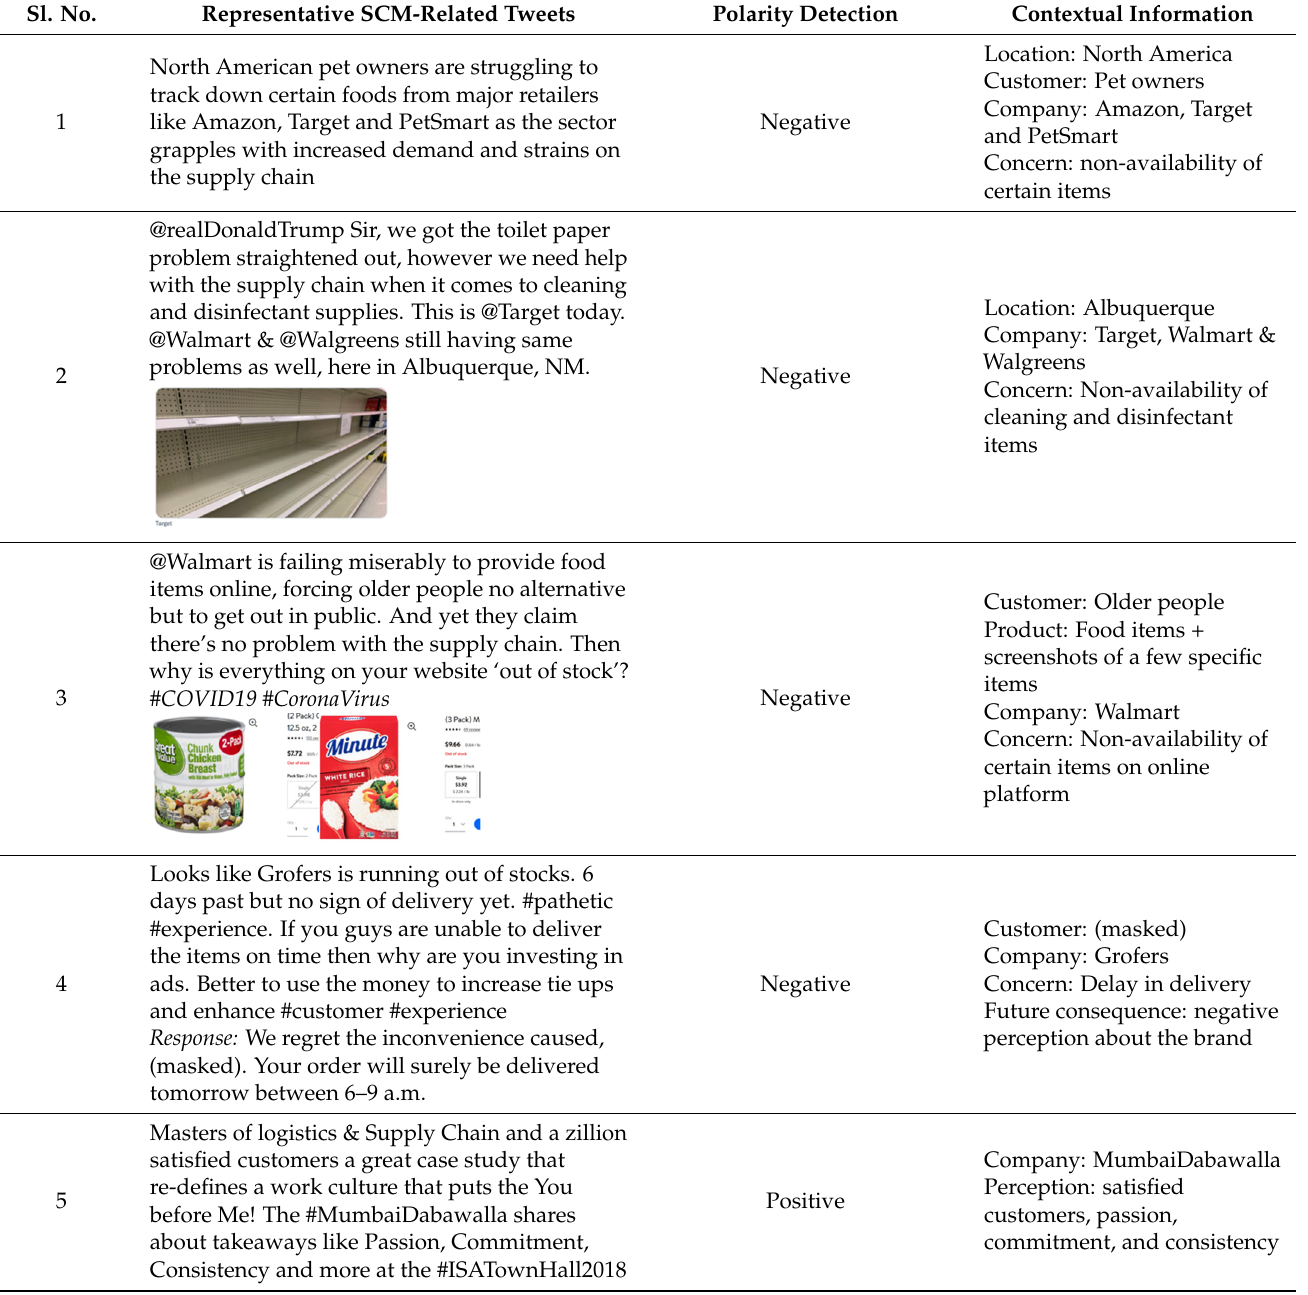
Table 4. Context-aware Sentiment Analysis: The Way Forward.